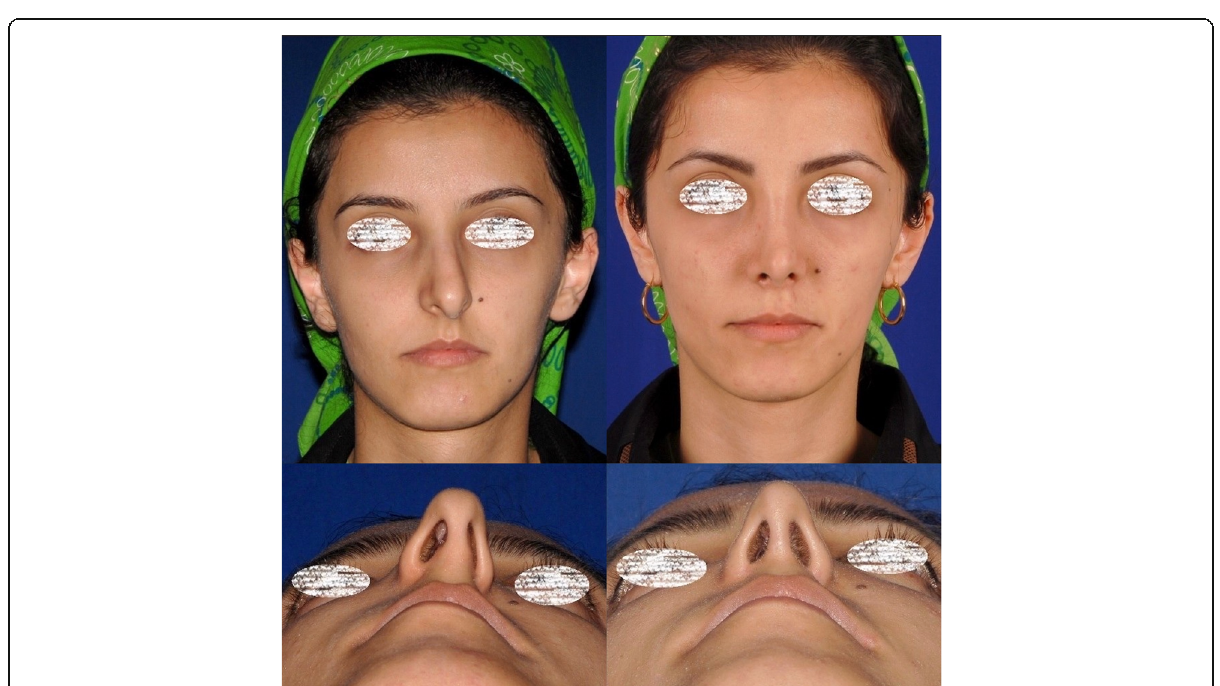
Fig. 4 Patient who underwent rhinoplasty with sill graft in preoperative and postoperative views from frontal ( a , b ) and basal ( c , d ) aspects. b , d Postoperative